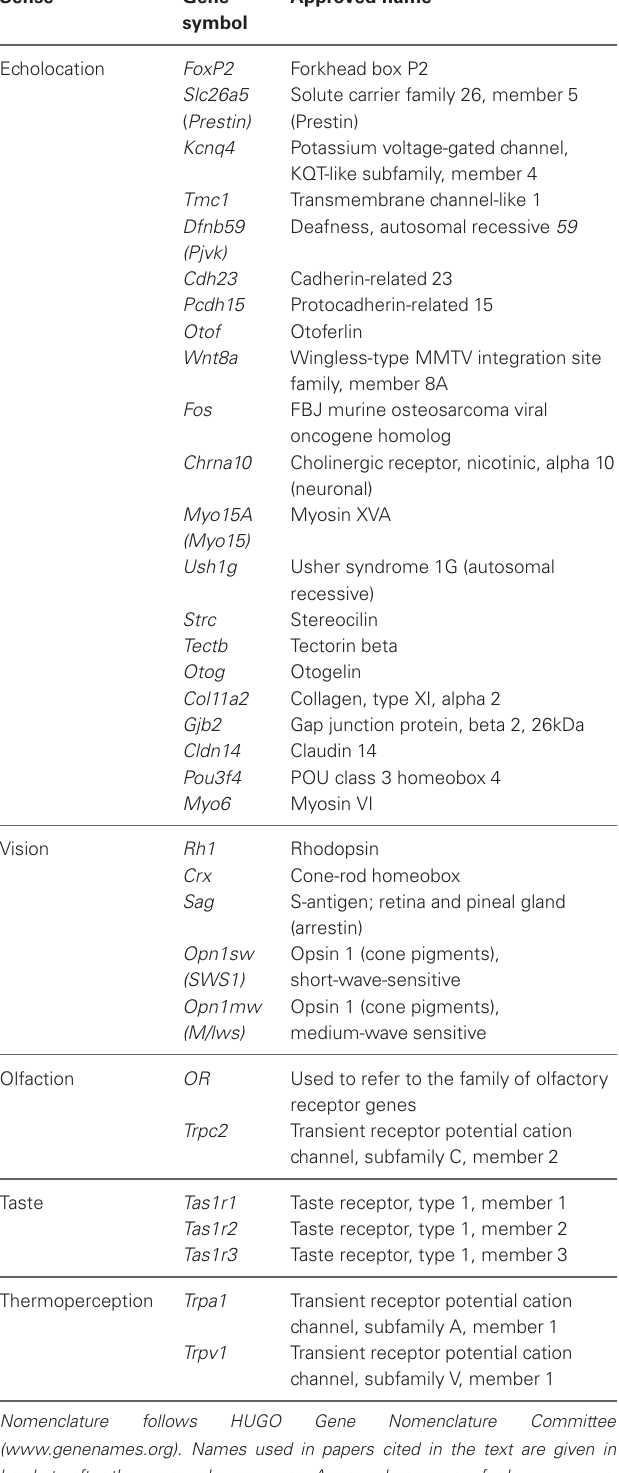
Table 1 | Genes referred to in the